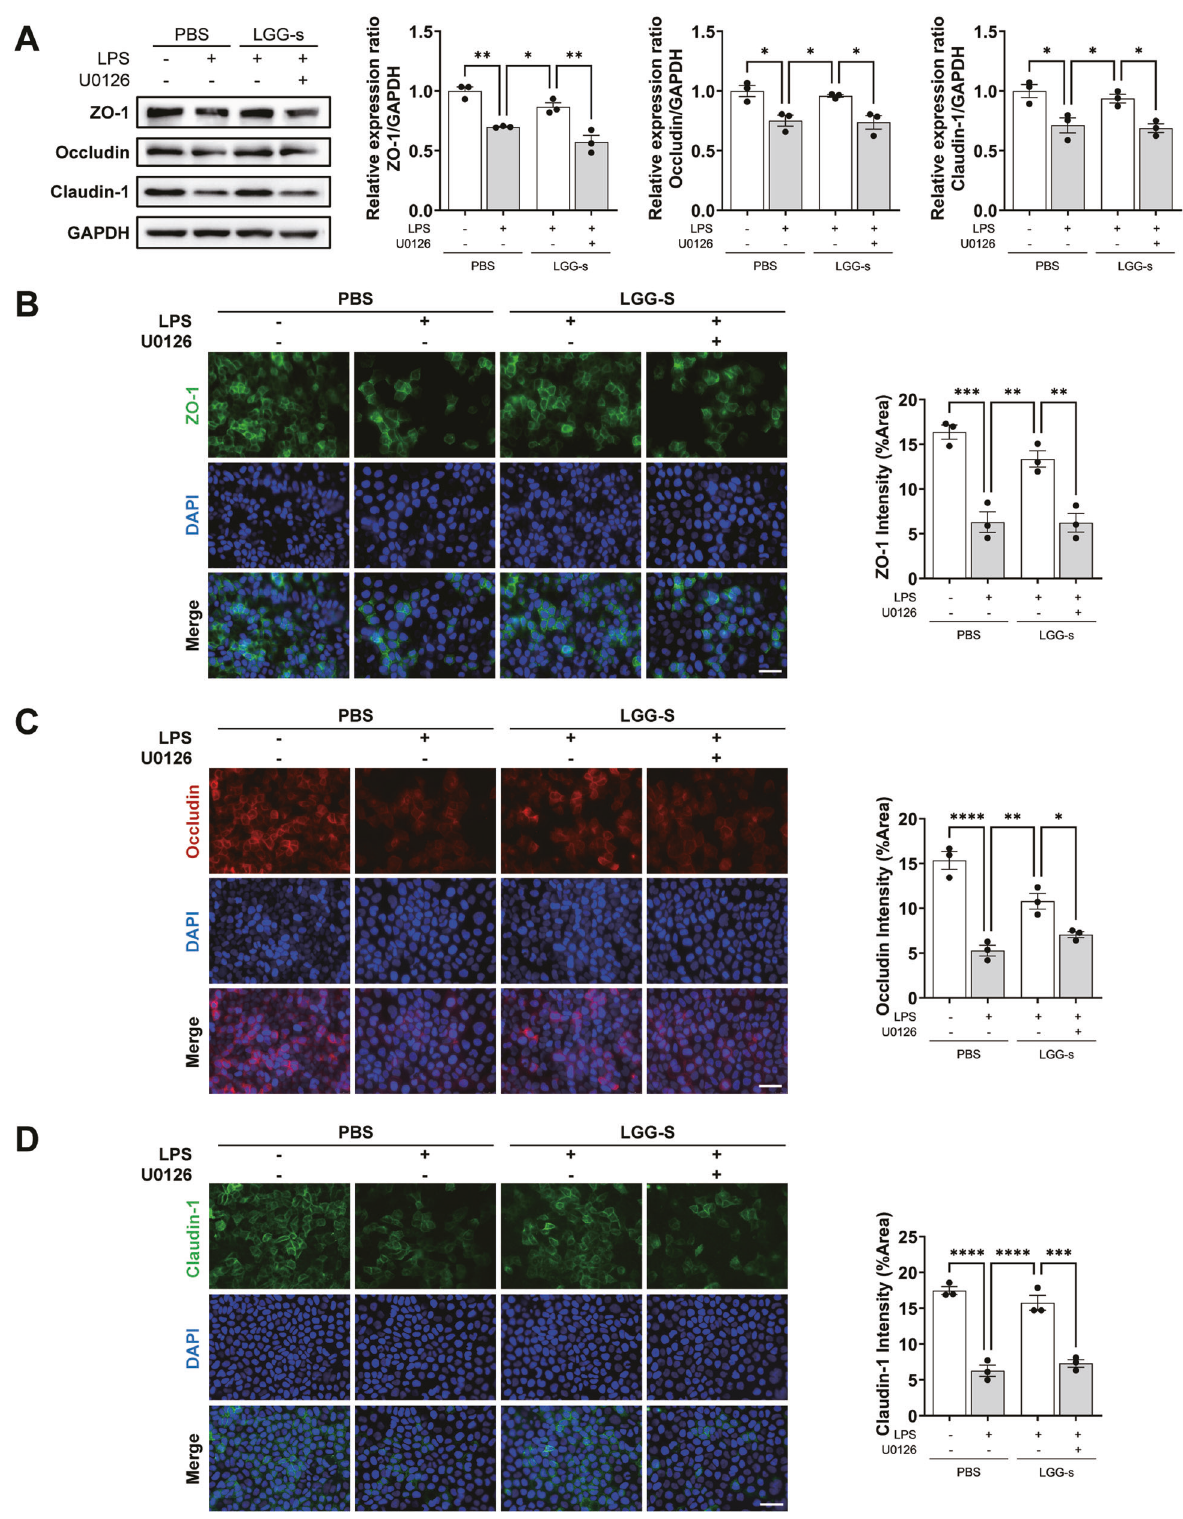
Fig. 7 LGG-s lost the improvement of barrier function after MEK inhibition. A Western blotting analysis for ZO-1, Occludin, and Claudin-1 normalized by GAPDH. B – D IF staining and quanti fi cation of ZO-1, Occludin, and Claudin-1. Scale bar = 50 μ m. Data are presented as mean ± SEM. Statistical analysis was performed using one-way ANOVA with Tukey multiple